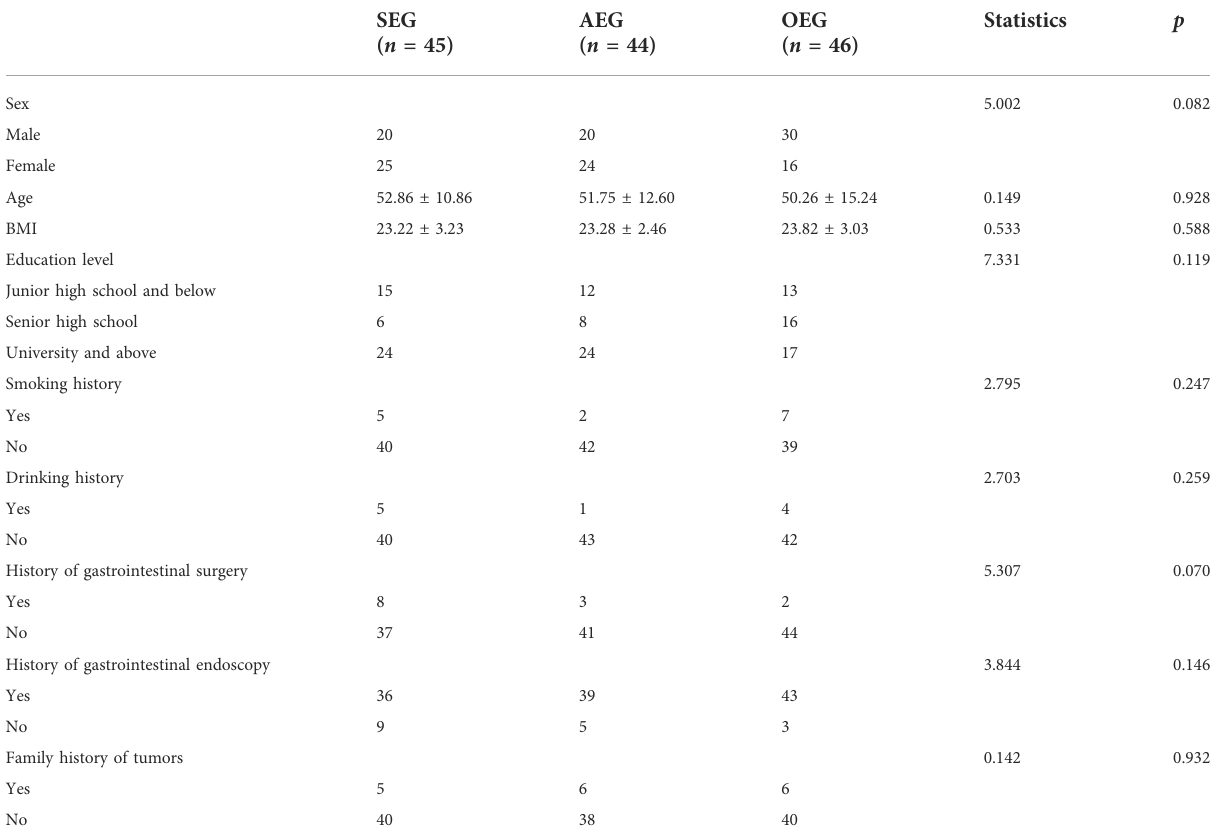
TABLE 2 Basic clinical characteristics of the enrolled